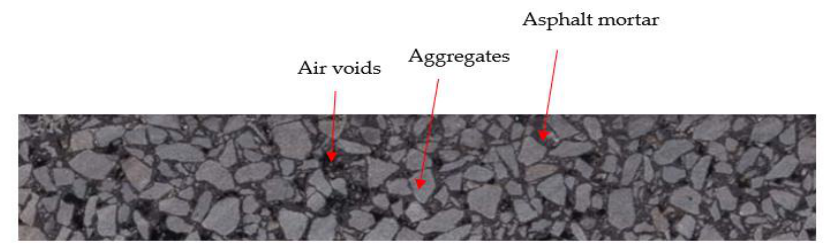
Figure 3. Initial Digital Image.